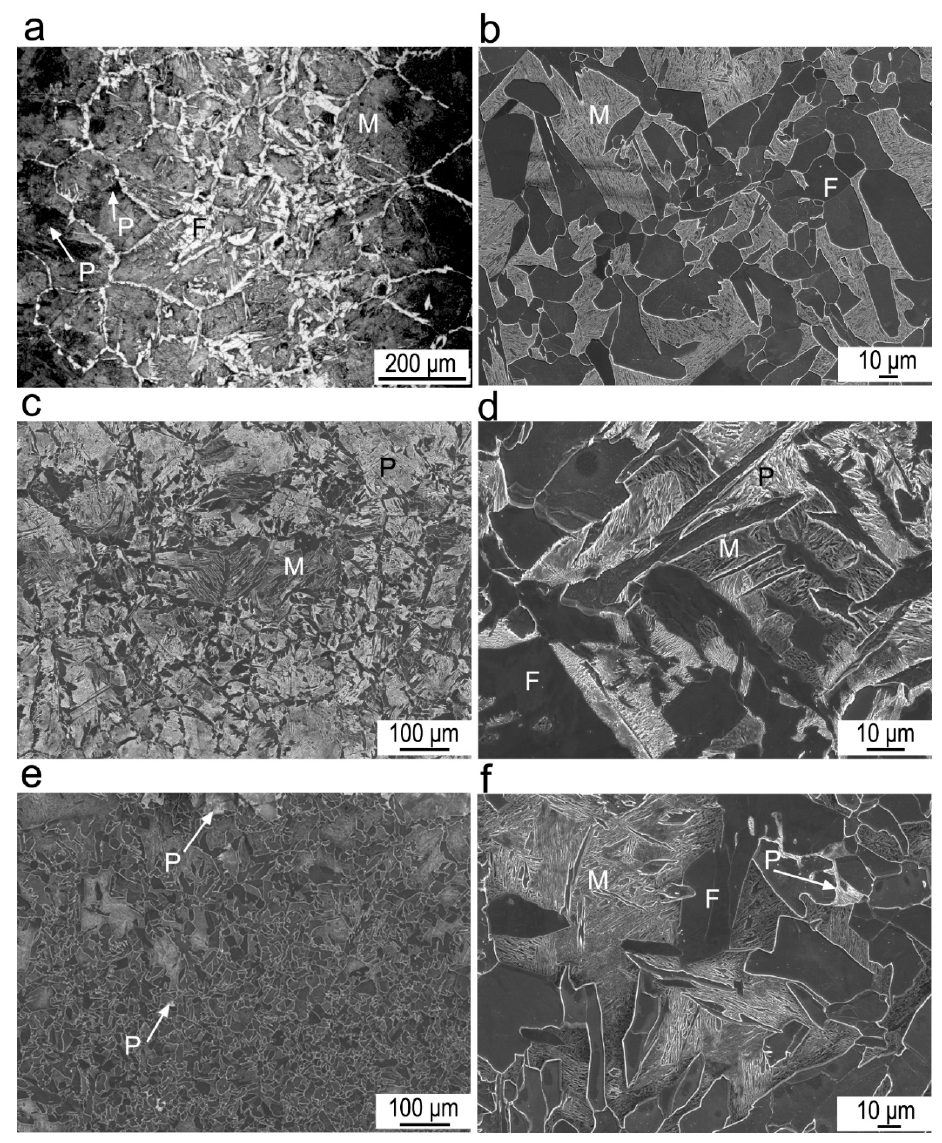
Figure 4. ( a ) Optical microscopy (OM) and ( b – f ) SEM microstructures after holding at ( a ) 620 °C for 180 s, ( b ) 670 °C for 300 s, ( c , d ) 630 °C for 180 s and ( e , f ) 650 °C for 180 s. F is ferrite, P is pearlite and 180 s, ( b ) 670 ◦ C for 300 s, ( c , d ) 630 ◦ C for 180 s and ( e , f ) 650 ◦ C for 180 s. F is ferrite, P is pearlite and M M is martensite. is Table 1. The fraction of ferrite as a function of holding temperature and time.